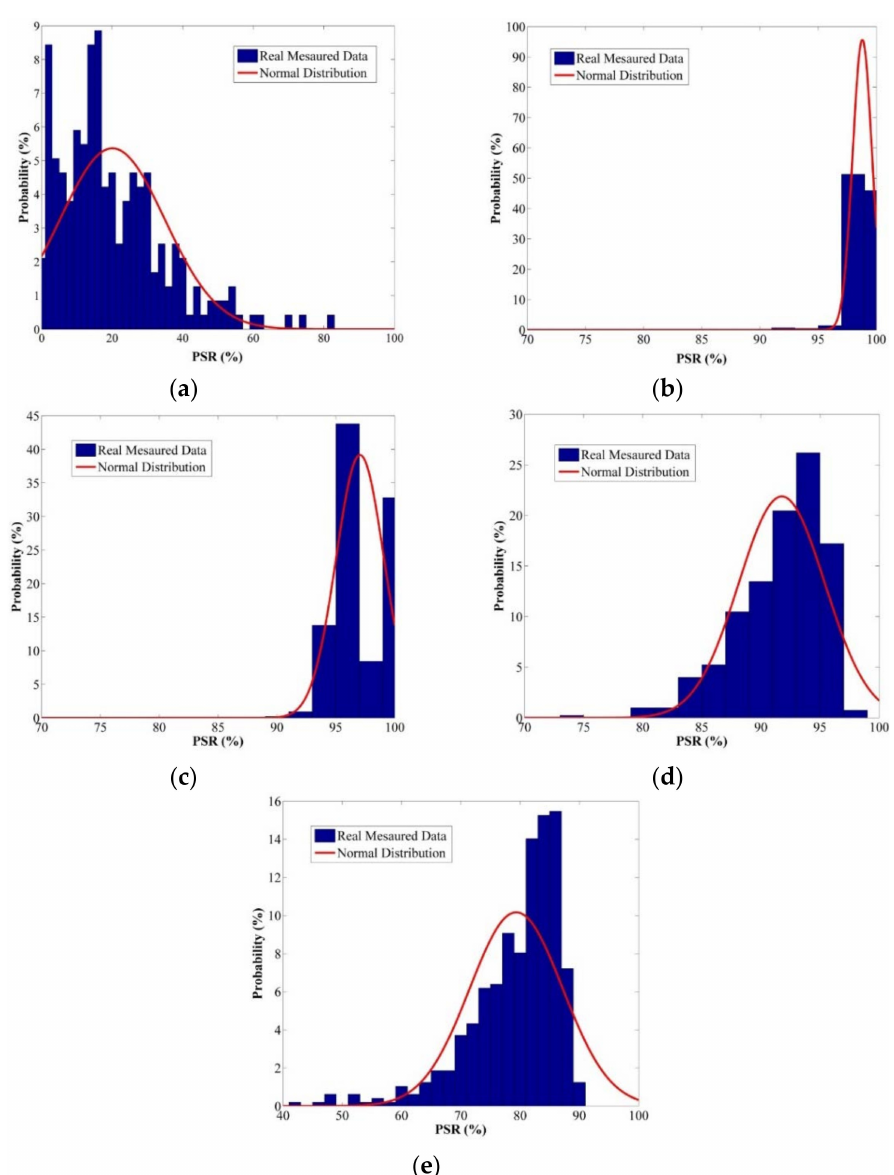
Figure 16. PSR PDFs for the experimental feeder. ( a ) PDF of LS_1; ( b ) PDF of LS_2; ( c ) PDF of LS_3; ( d ) PDF of LS_4; ( e ) PDF of LS_5.